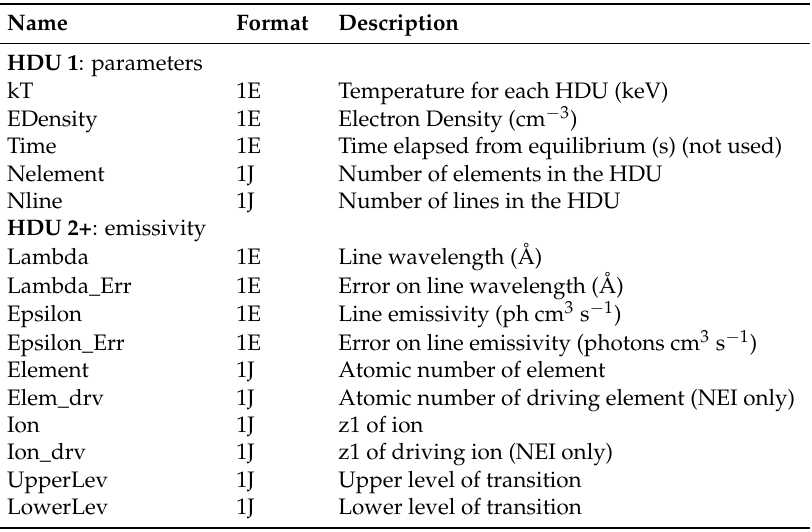
Table A12. APEC Line Emission file definition. HDU 1 lists the plasma parameters for each HDU, HDU 2+ are the spectrum for each of those plasams defined in HDU